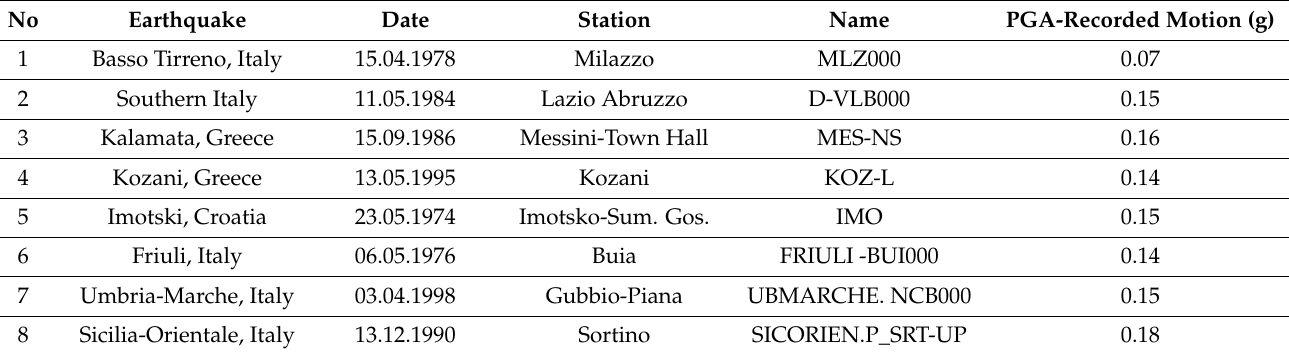
Table 2. Ground motion ensemble used for the Incremental Dynamic Analysis.